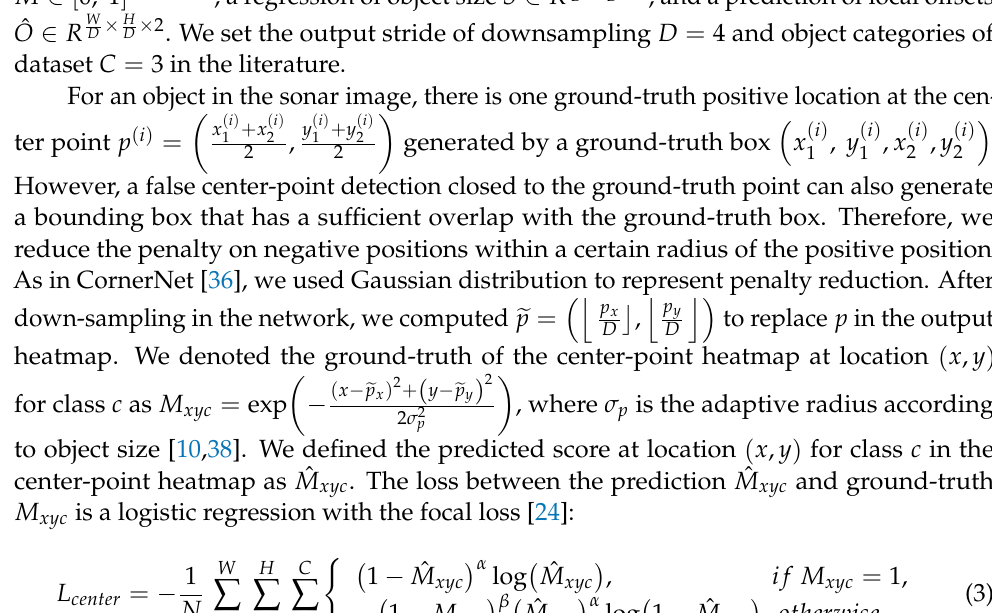
Figure 11. Some examples of the ground-truth in the dataset.